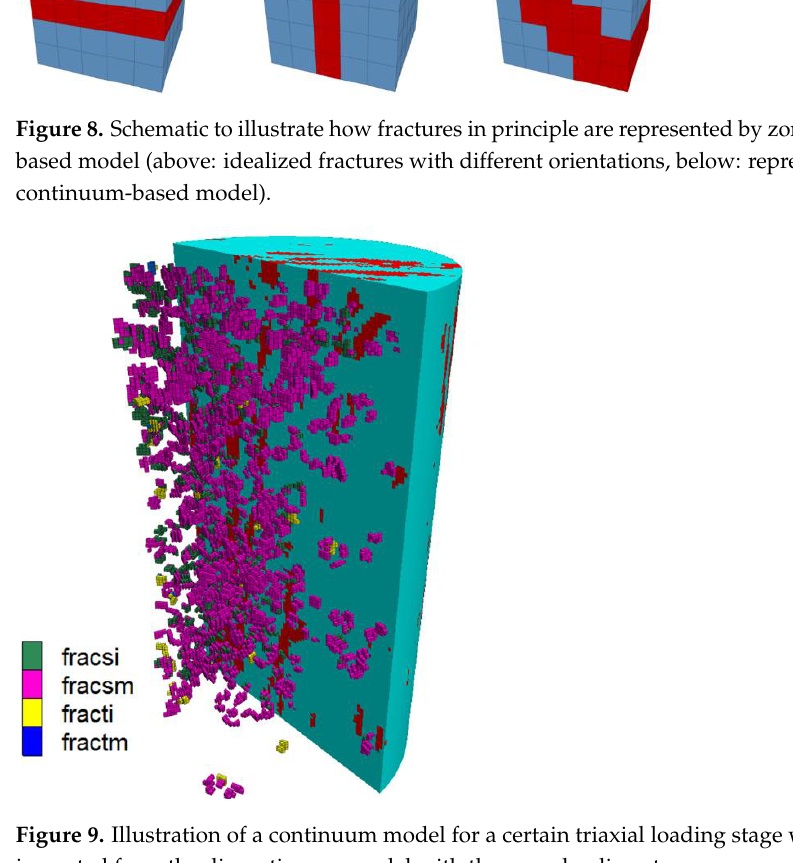
Figure 9. Illustration of a continuum model for a certain triaxial loading stage with four crack types imported from the discontinuum model with the same loading stage.